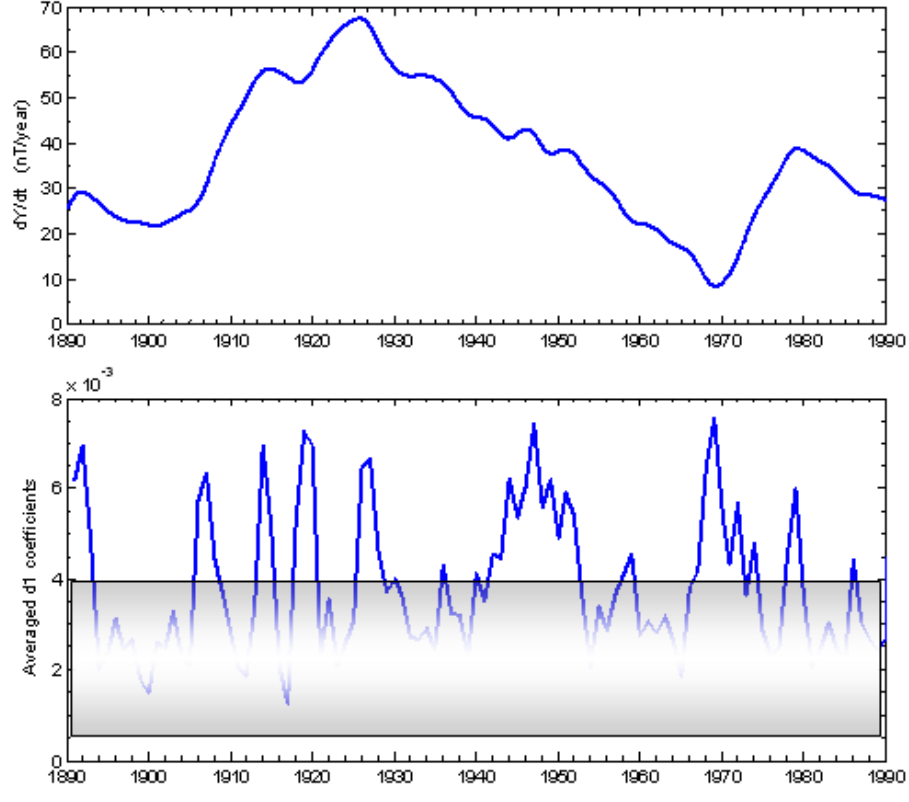
Fig. 9. Monthly series of secular variation of Y component generated by Gufm1 model at NGK Observatory coordinates for the period 1890–1990 (upper panel) and averaged rms d 1 coefficients of the series decomposition by Db2 wavelets of level 2. The rms d 1 coefficients (in nT/year) below their mean value are